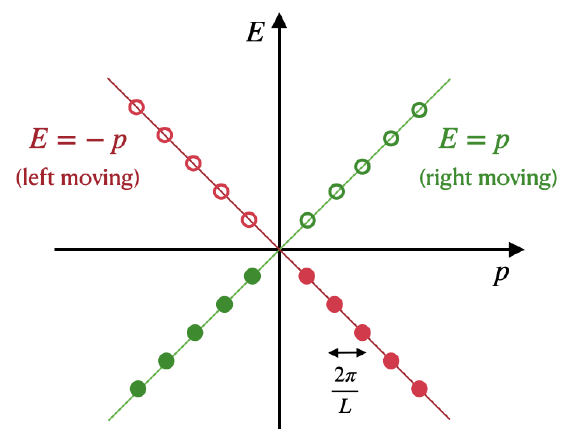
Figure 5. Spectrum for the left-handed and right-handed fermions with all negative energies filled corresponding to the Dirac sea and therefore to our